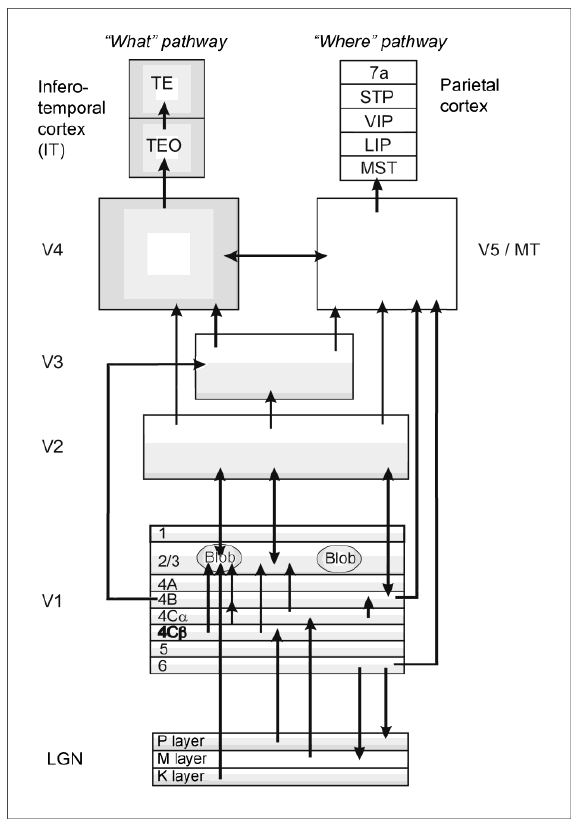
Figure 1. Schematic representation of the primate visual pathways. The left half of the figure represents the ventral (―what‖) stream, while the right side shows the hierarchical organization of the dorsal (―where‖) stream. Abbreviations: LGN—Lateral geniculate nucleus, V1, V2, V3, V4—Primary (first), second, third, fourth visual cortices, respectively, TEO—Posterior inferior temporal cortex, TE—Anterior inferior temporal cortex, V5/MT—Middle temporal area (fifth visual cortex), MST—Medial superior temporal area, LIP—Lateral intraparietal area, VIP—Ventral intraparietal area, STP—Superior temporal polysensory area, 7a—Visual area 7a in the parietal cortex (Brodmann‘s